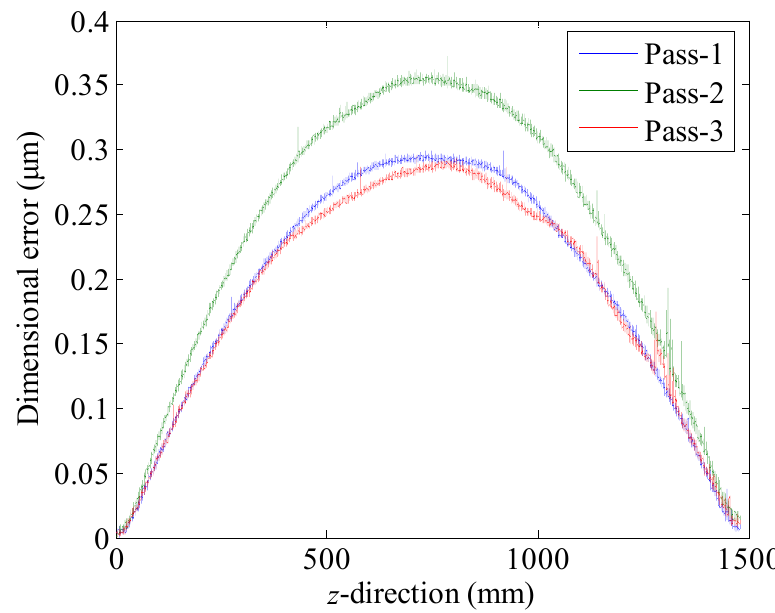
Figure 15. The dimensional errors of rough grinding passes.